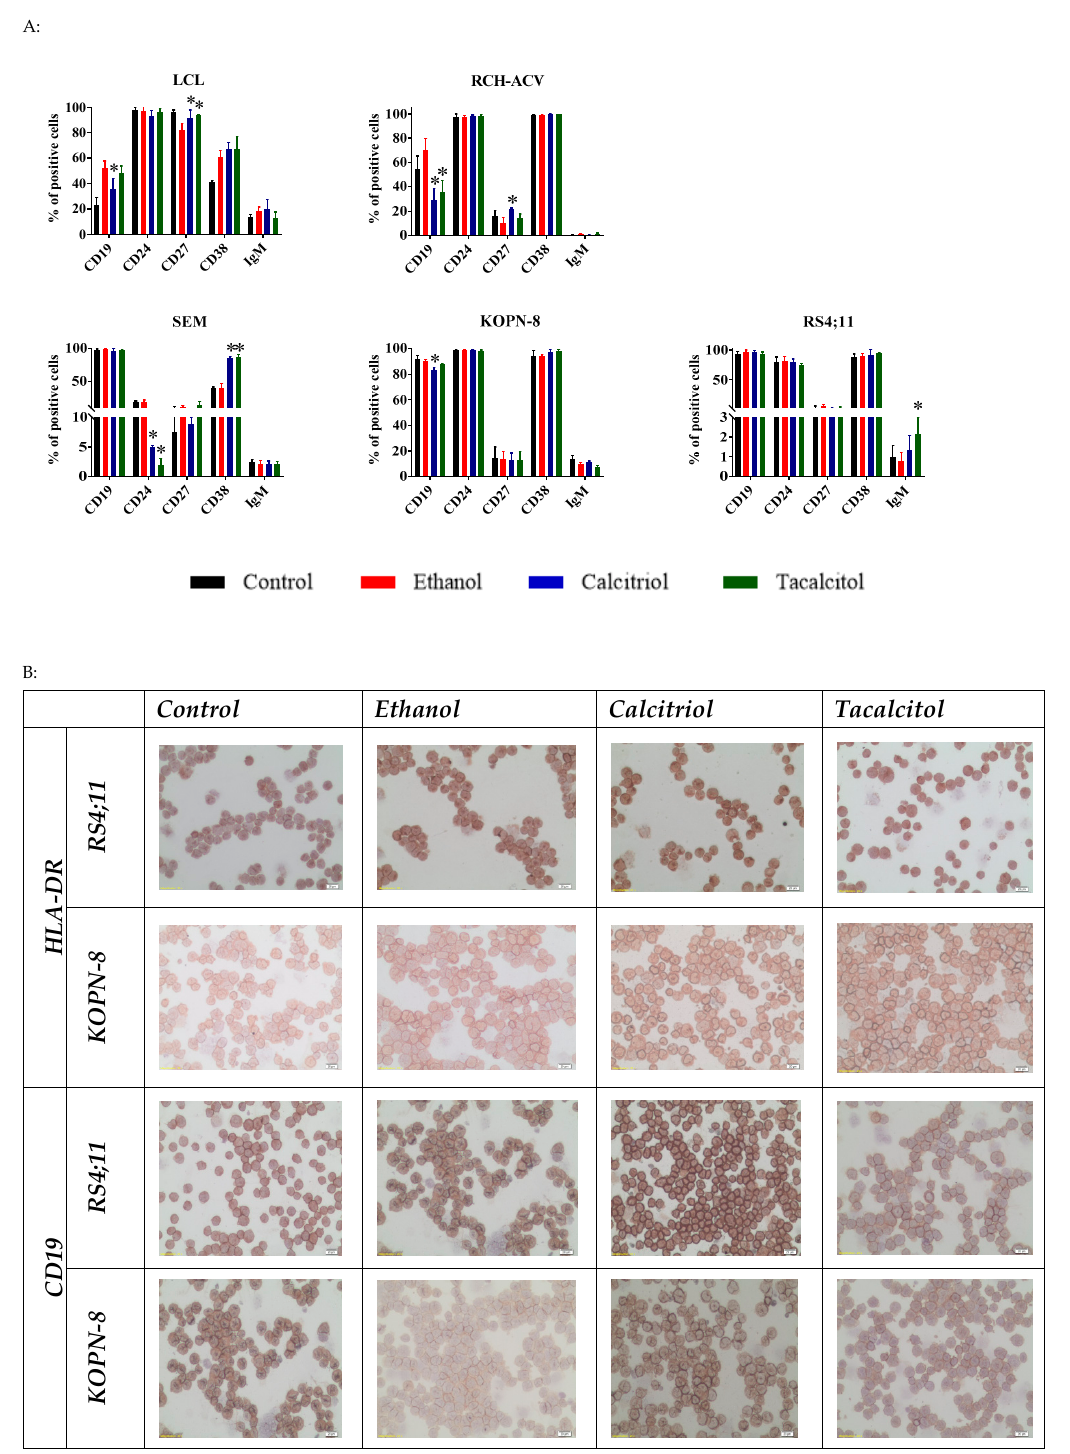
Figure 8. The direct effects of calcitriol and tacalcitol on the distribution of CD markers on normal and leukemic B cells. Cells were incubated for 96 h with 10 nM of calcitriol and tacalcitol or 1% ethanol: ( A ) flow cytometry distribution of CD markers. Mean values and standard deviation are presented. Statistical analysis: Sidak’s multiple comparisons test; significant differences as compared with ethanol (* p < 0.005). The graphs represent data from at least three separate experiments; ( B ) localization of HLA-DR and CD19 in B leukemic cells. Scale bar 10 µ m. Each staining was performed at least